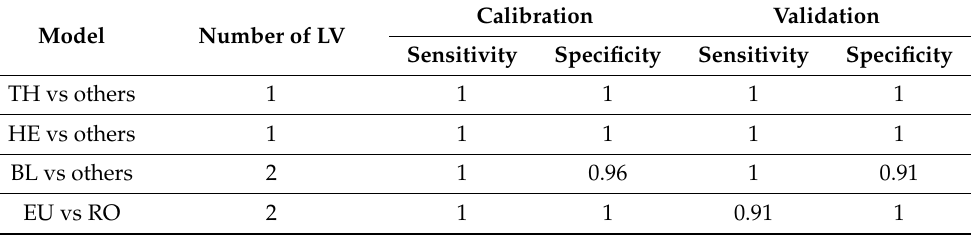
Table 2. Results from two-class classification models obtained by PLS-DA according to the calibration